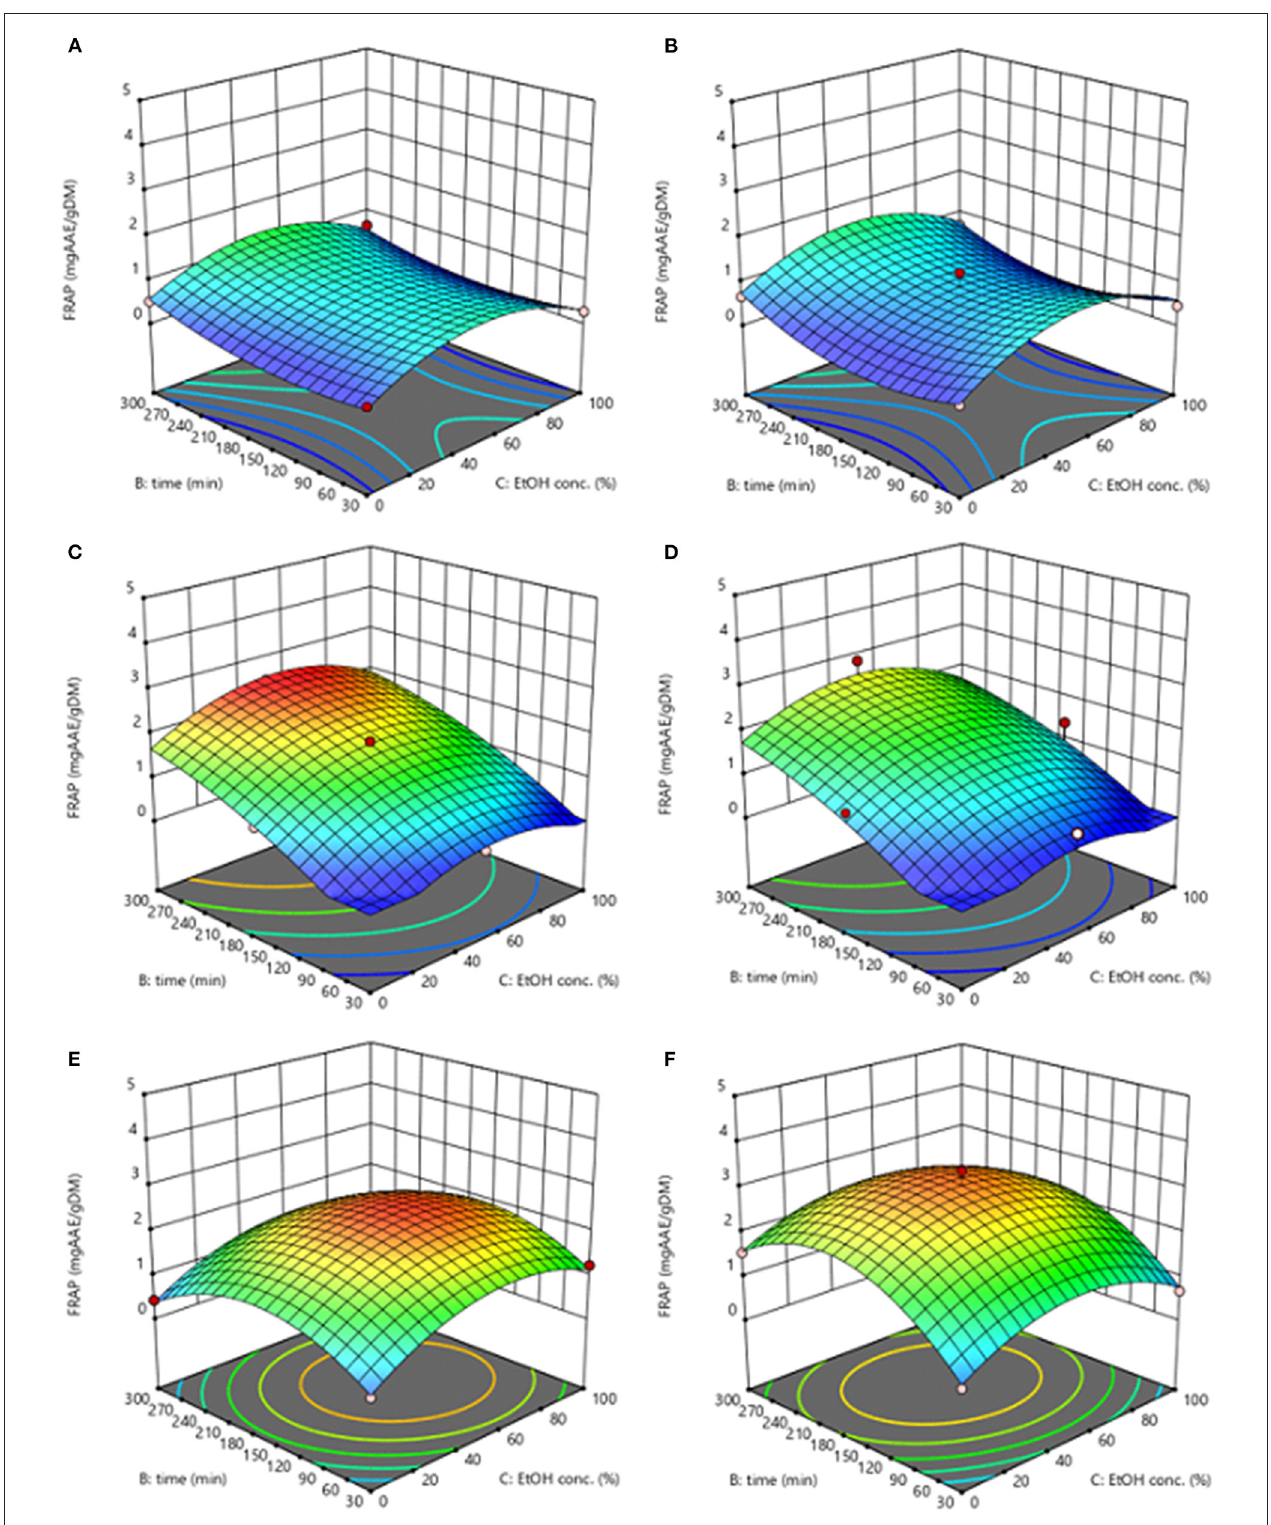
FIGURE 4 | Response surfaces for antioxidant activity (FRAP) of extracts obtained from untreated (Control) (A,C,E) and PEF-treated (E = 3.8 kV/cm; W T = 10kJ/kg) (B,D,F) grape pomace as a function of extraction time and ethanol concentration, with the extraction temperature set at 20 ◦ C (A,B) , 35 ◦ C (C,D) , 50 ◦ C (E,F) .